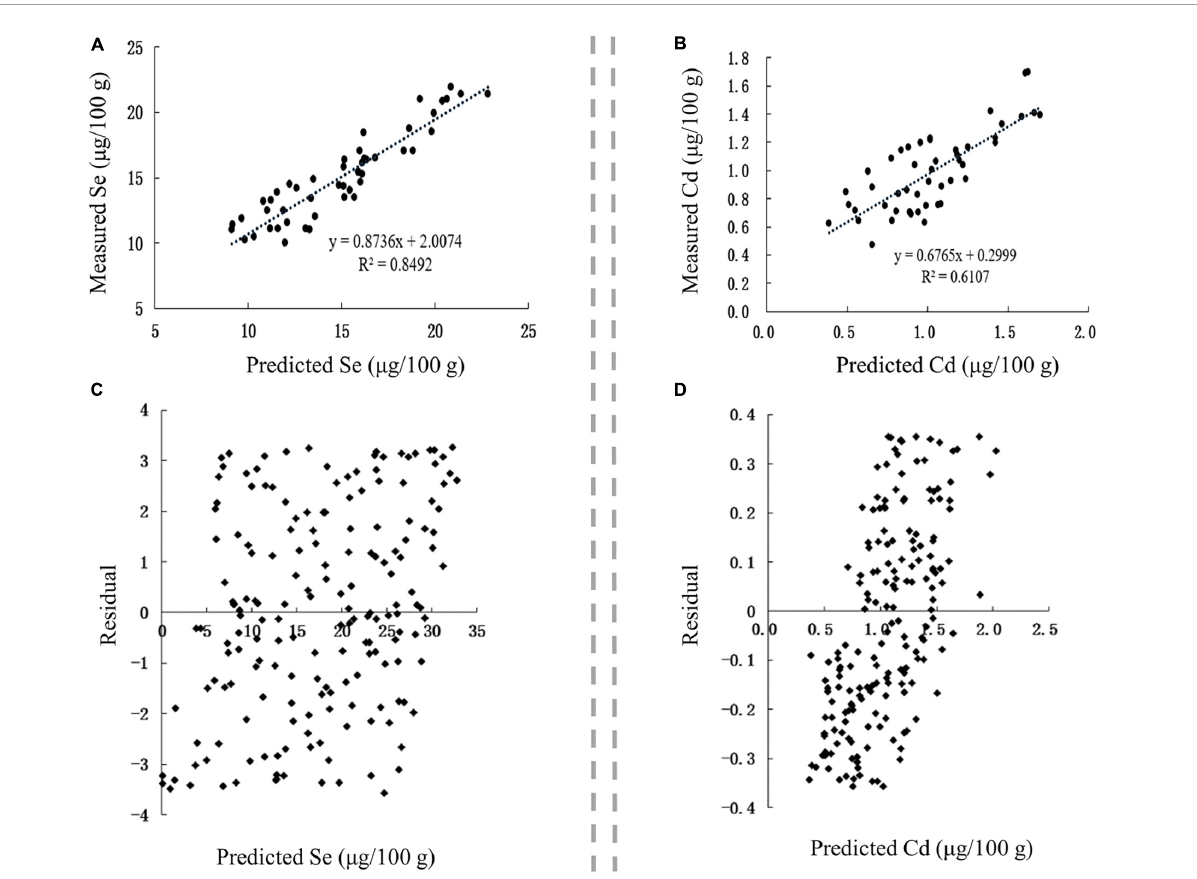
FIGURE7 Validation of prediction models in Se-rich rice grain. (A,B) Correlation between the fitted and measured Se and Cd contents, respectively. (C,D) Residual analysis of the fitted and measured Se and Cd contents, respectively.